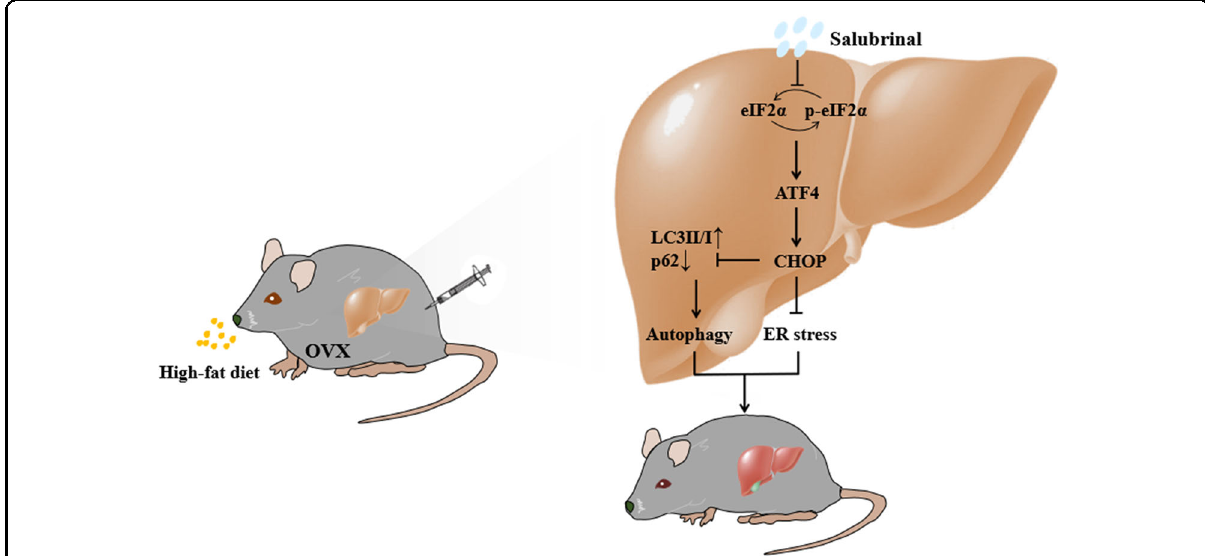
Fig. 8 Mechanism of salubrinal ’ s action in hepatic steatosis. Salubrinal alleviated hepatic steatosis and lipidosis by inhibiting the ER stress and alerting autophagy through eIF2 α